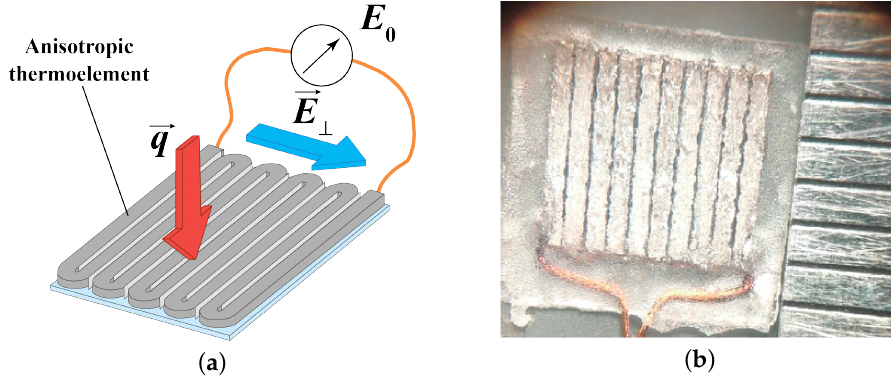
Figure 2. GHFS scheme ( a ) and general view ( b ) [14]: 1—anisotropic thermopower element (ATE); 2—mica; 3—bismuth soldering; 4—current leads; 5—lavsan